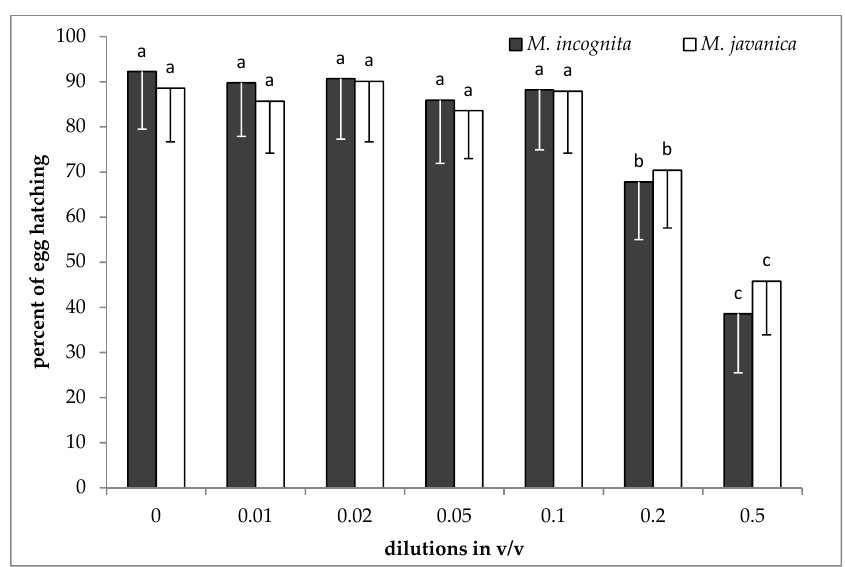
Figure 4. E ff ect of hydrosol on hatching of M. incognita and M. javanica J2s after immersion in test solutions, at the doses of 0, 0.01, 0.02, 0.05, 0.1, 0.2 and 0.5 v / v for 28 days. Bars with the same color followed by the same letter are not significantly di ff erent. Error bars represent the standard deviation of mean.